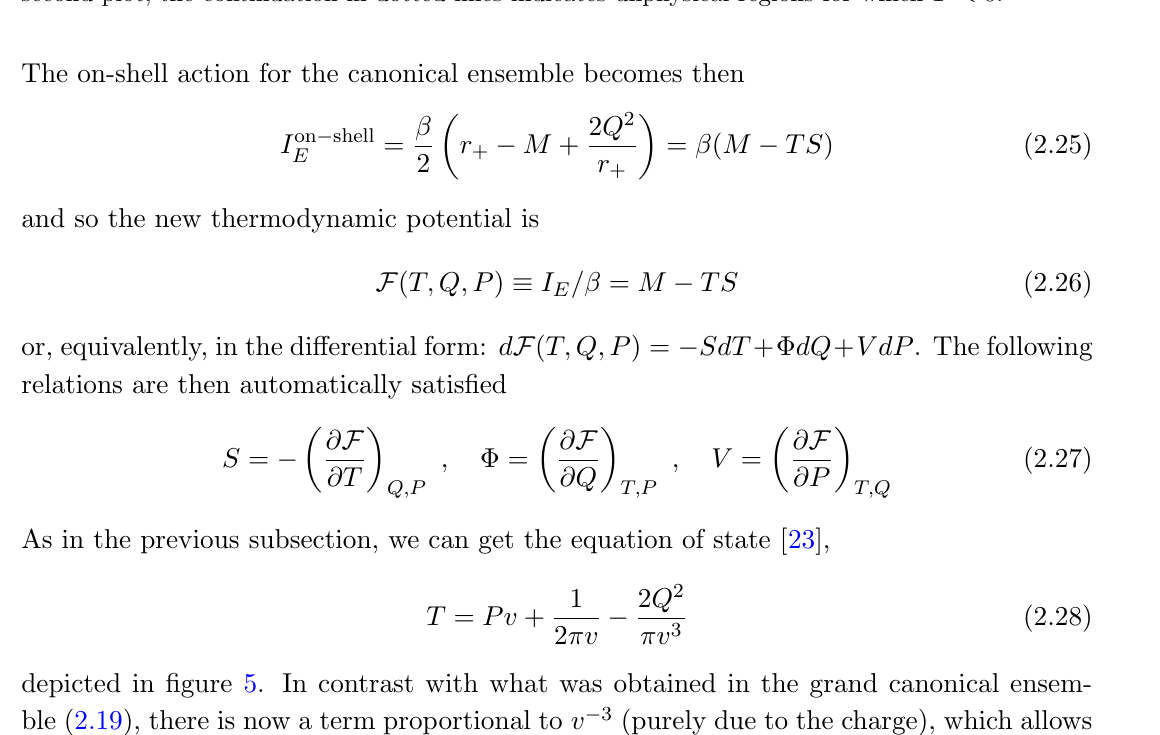
Figure 4 . Heat capacity as a function of the entropy, for (cid:8) = 0 : 8 and (cid:8) = 1 : 4. In the (cid:12)rst case, representing 0 < (cid:8) < 1, we observe small thermally unstable and large thermally stable black holes. For the second case, representing (cid:8) > 1, the black holes become thermally stable, C (cid:8) > 0. In the second plot, the continuation in dotted lines indicates unphysical regions for which T <